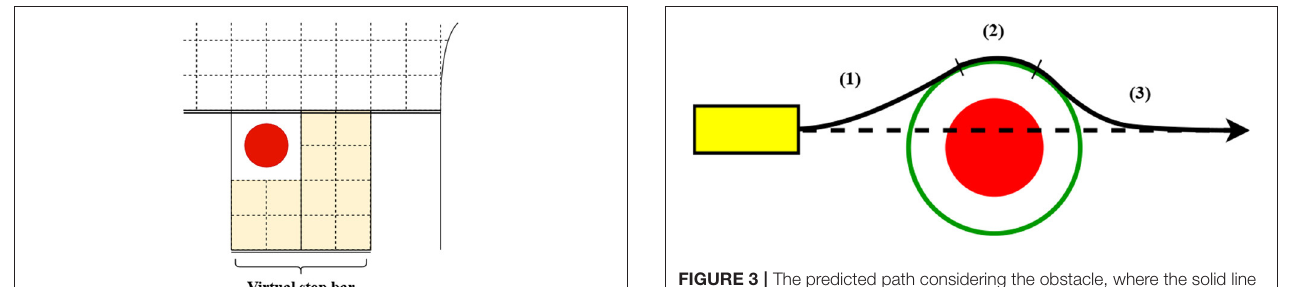
FIGURE 3 | The predicted path considering the obstacle, where the solid line represents path from the collision avoidance algorithm while the dashed line represents the normal predicted